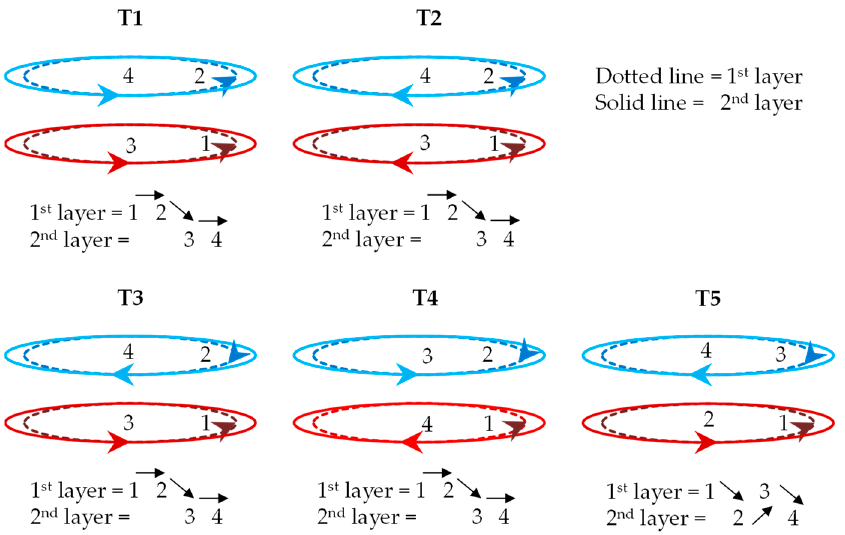
Figure 11. Comparison of various welding trajectories for 2 × 2 pattern. The red and blue circles indicate the welding path, while the arrows represent the welding direction of the beads. Inner dotted circles represent the beads of the first layer, while the solid outer circles depict the beads of the second layer. The welding sequence of the beads in the two layers is indicated by the numbers above the circles and the path under each trajectory. For example, in trajectory T1, the first bead was welded in the first layer, followed by the second bead in the first layer. Then the third and fourth beads are welded in the second layer, and so on.